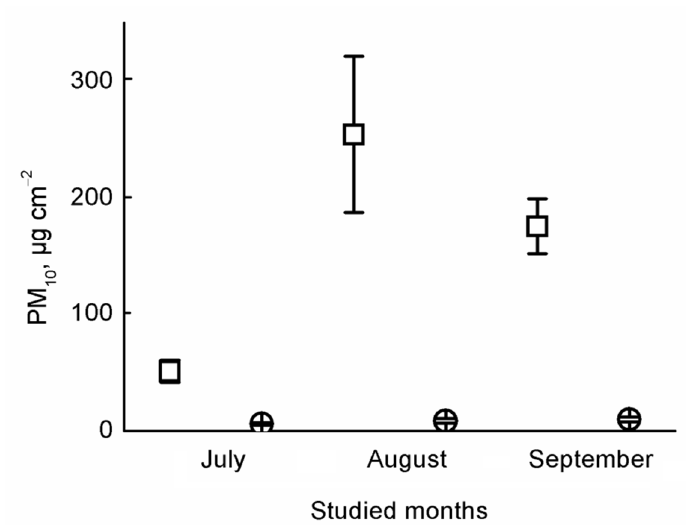
Figure 1. Average (± standard error) concentrations of PM 10 in the leaves and traps. Notations: open square means PM 10 concentrations in traps, open circle means PM 10 concentrations on leaves.